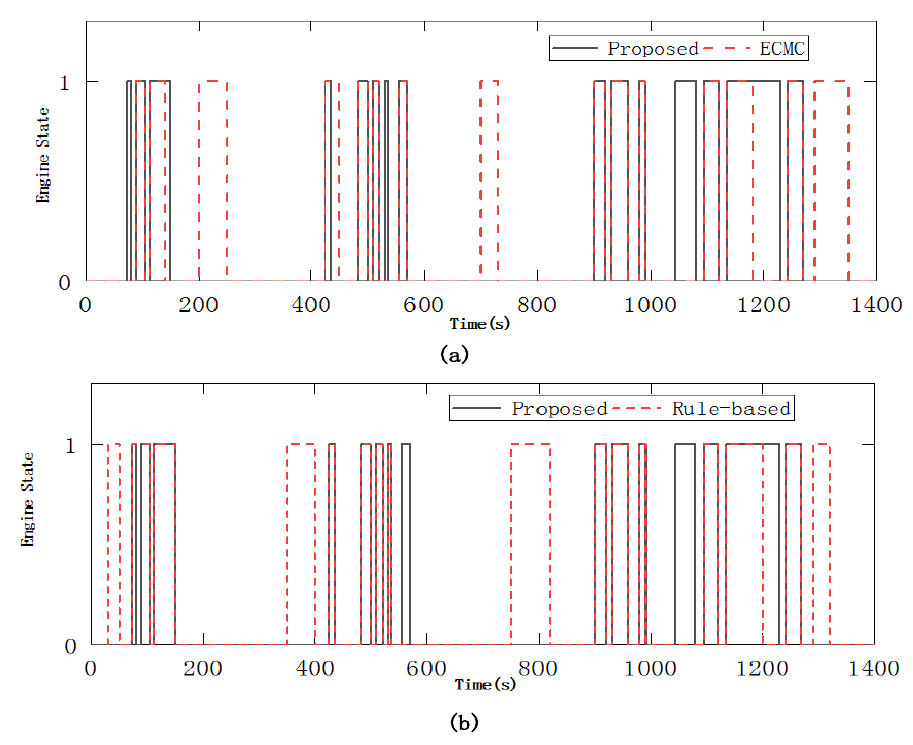
Figure 18. Comparison of engine start-stop times between three strategies. ( a ) the proposed strategy and the ECMC; ( b ) the proposed strategy and the rule-based strategy.